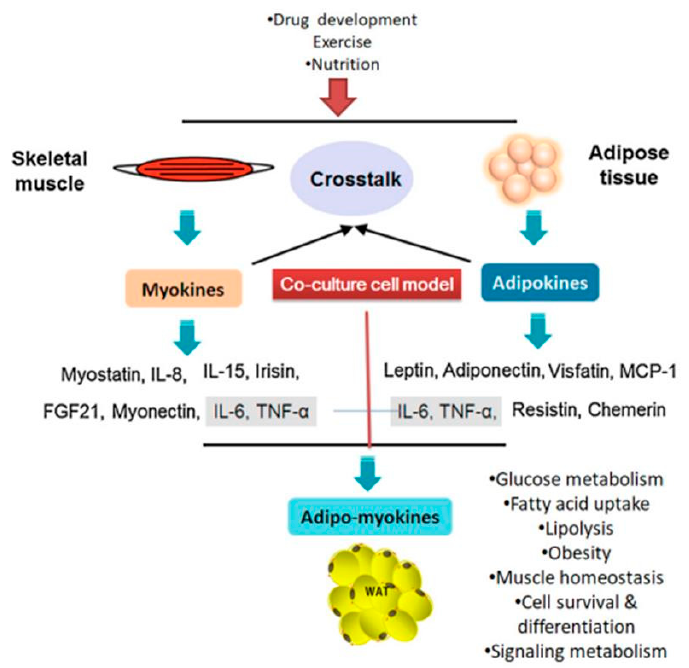
Figure 1. Cross-talk between muscle and adipose tissues is regulated by various secretory factors (adapted and modified from Li et al. (2017) [14]). WAT: white adipose tissue; TNF- α - tumor necrosis growth factor- alpha; FGF21: fibroblast growth factor 21; IL: interleukin.